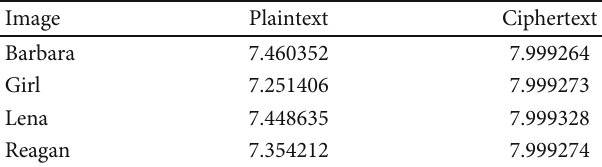
Table 9: Local information